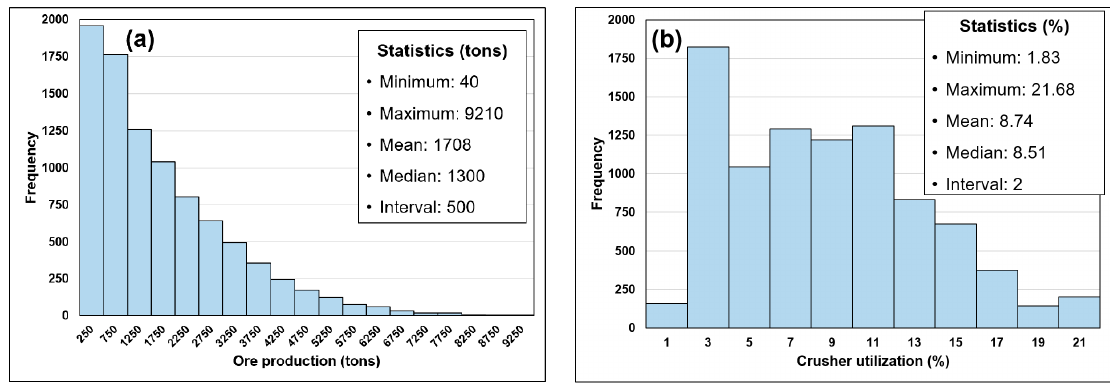
Figure 4. Histogram of training data: ( a ) ore production; ( b ) crusher utilization.